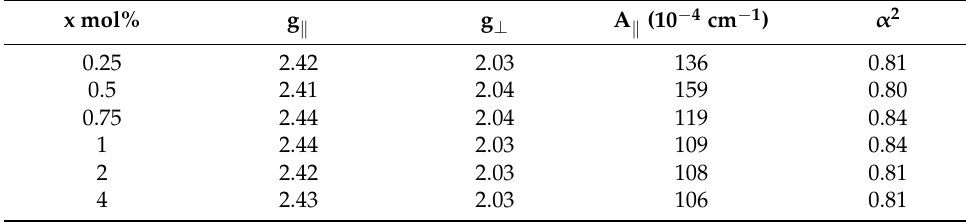
Table 4. EPR parameters for xCuO∙(100 − x)[CaF 2 ∙3P 2 O 5 ∙CaO] .